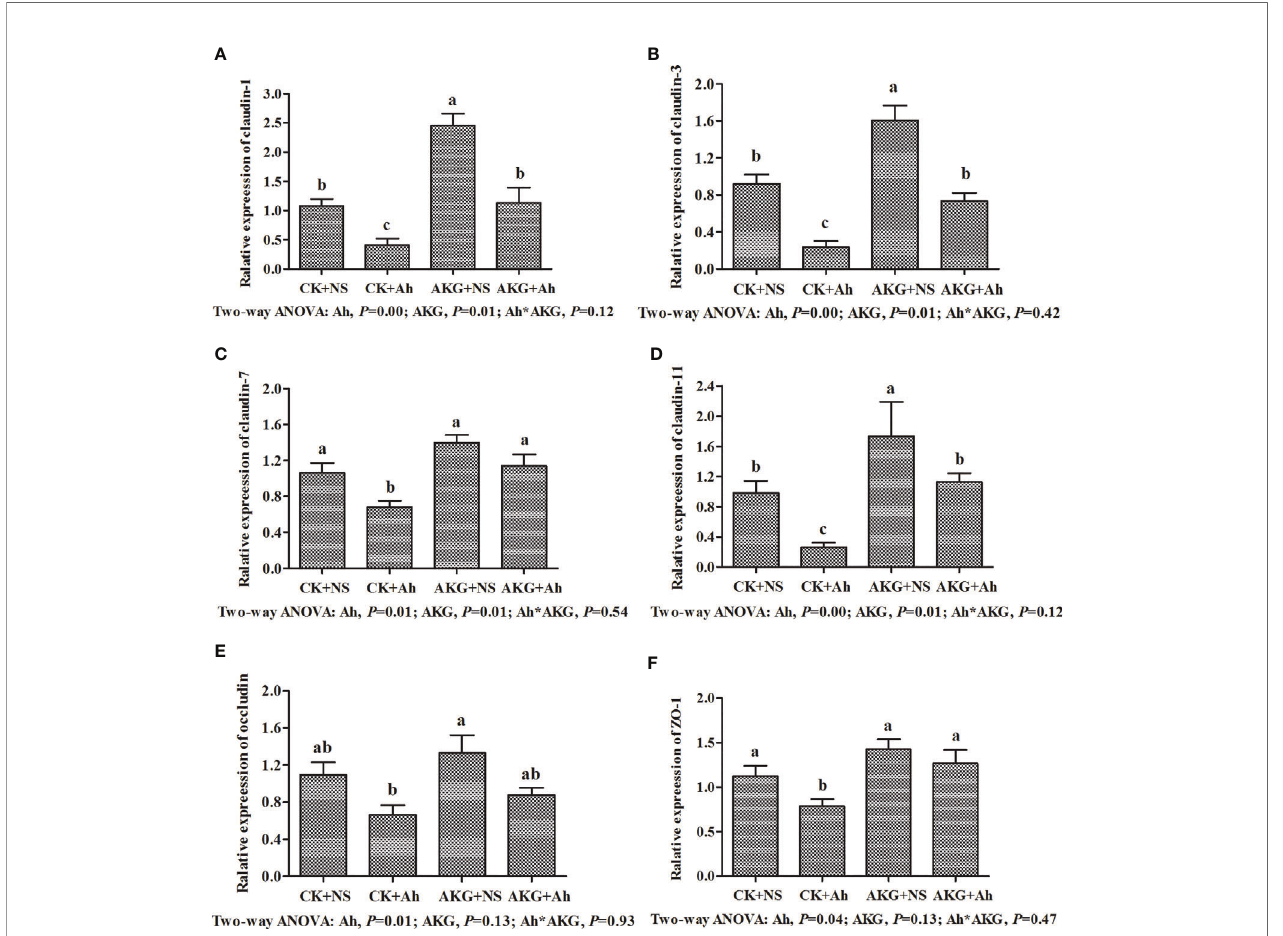
FIGURE 6 | Effects of AKG supplementation and A hydrophila infection on relative mRNA expression levels of immune-related MLCK signaling pathway of Songpu mirror carp ( Cyprinus carpio ). (A) claudin-1; (B) claudin-3; (C) claudin-7; (D) claudin-7; (E) occludin; (F) ZO-1, zonula occludens-1. All of the values are expressed as the means ± SEM. Values with different letters are signi fi cantly different ( P <